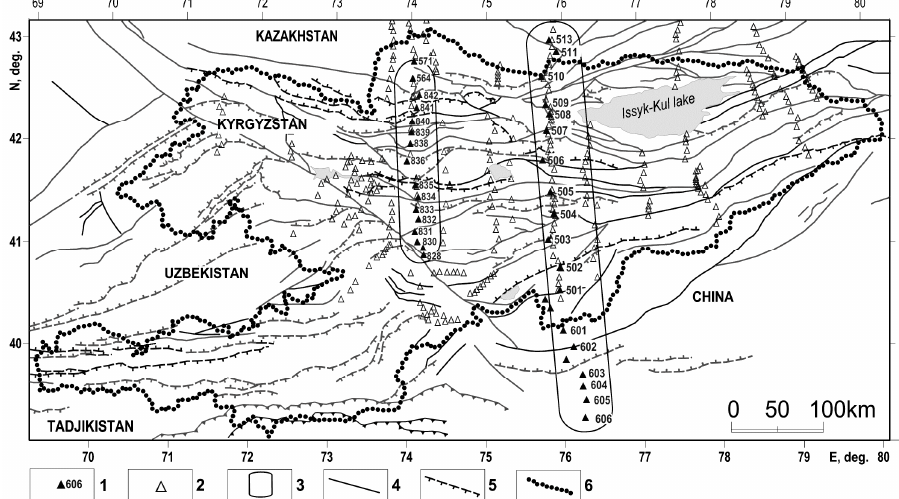
Fig. 1. Scheme of geoelectric exploration of the Central Tien Shan: 1 - points of deep magnetotelluric sounding (DMTS); 2 - points of magnetotelluric sounding (MTS); 3 - MTS profiles considered in the work; 4 - fault structures; 5 - thrusts; 6 - border of the Kyrgyz Republic